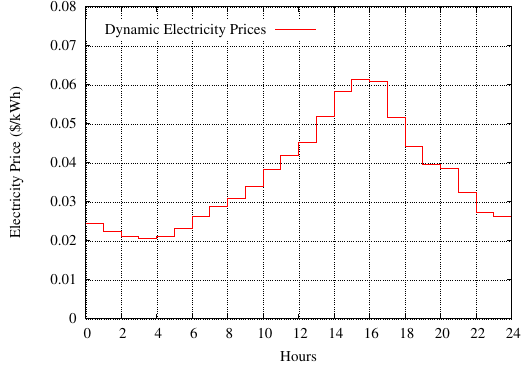
Figure 7. Dynamic electricity prices [29].